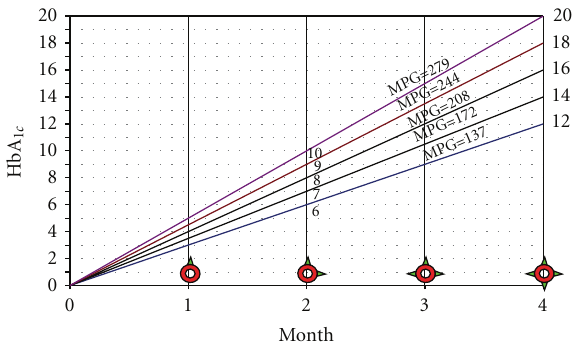
Figure 2: Rate of formation of HbA 1c simulated from results of pro- longed incubation of HbA 0 with glucose in di ff erent concentration.